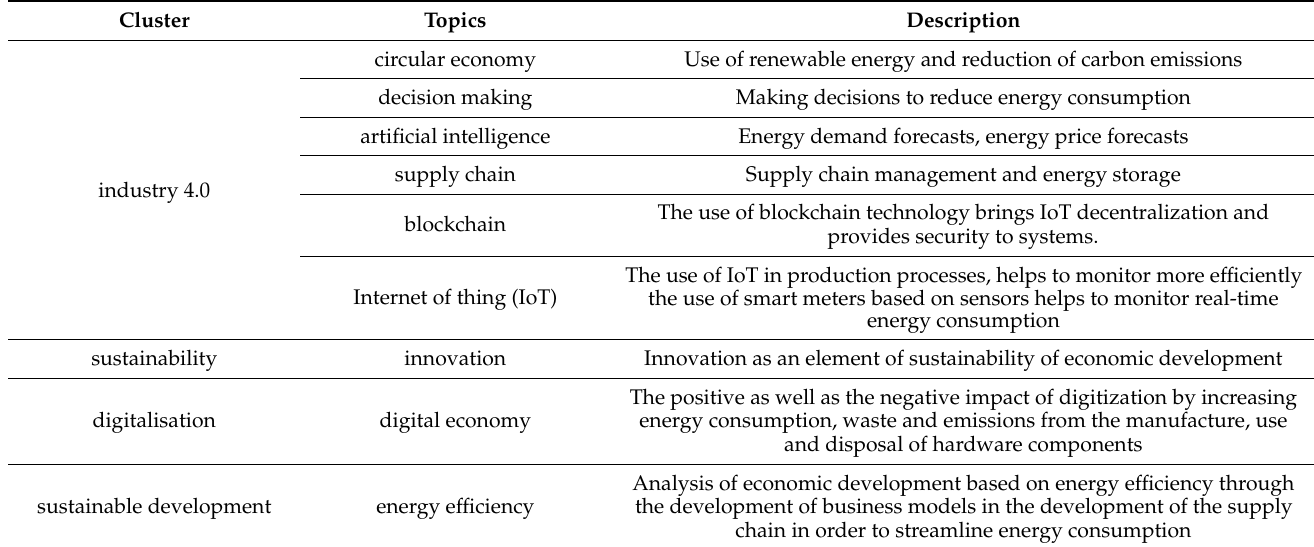
Table 2. The main clusters and topics description.